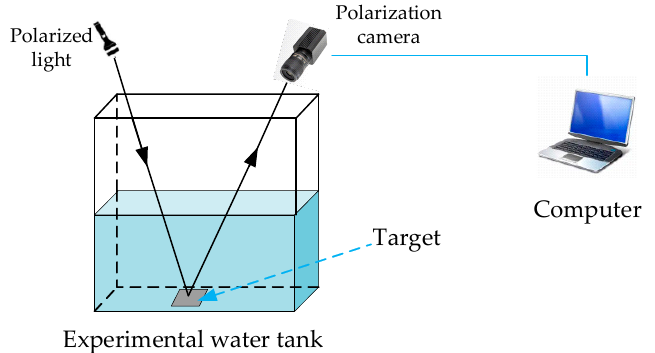
Figure 6. Experimental platform for underwater polarization imaging.